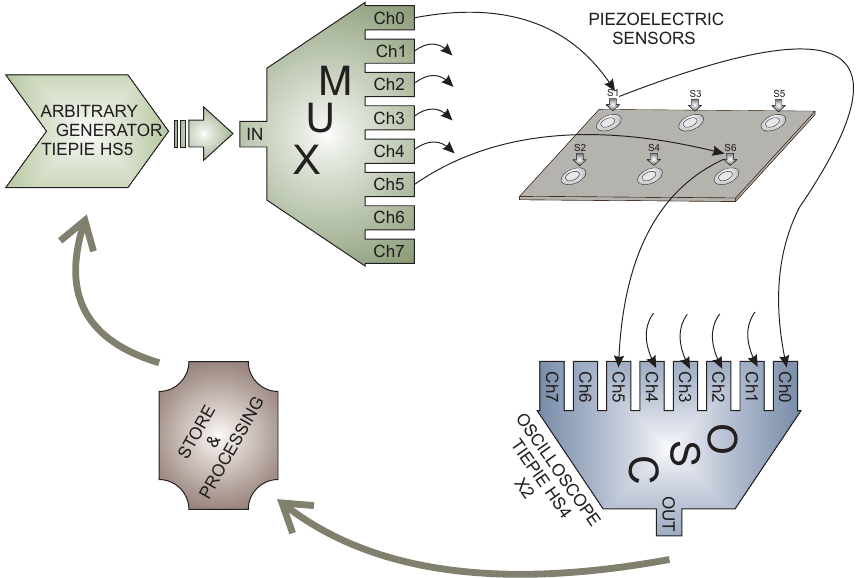
Figure 3. Representation of the structural health monitoring (SHM)